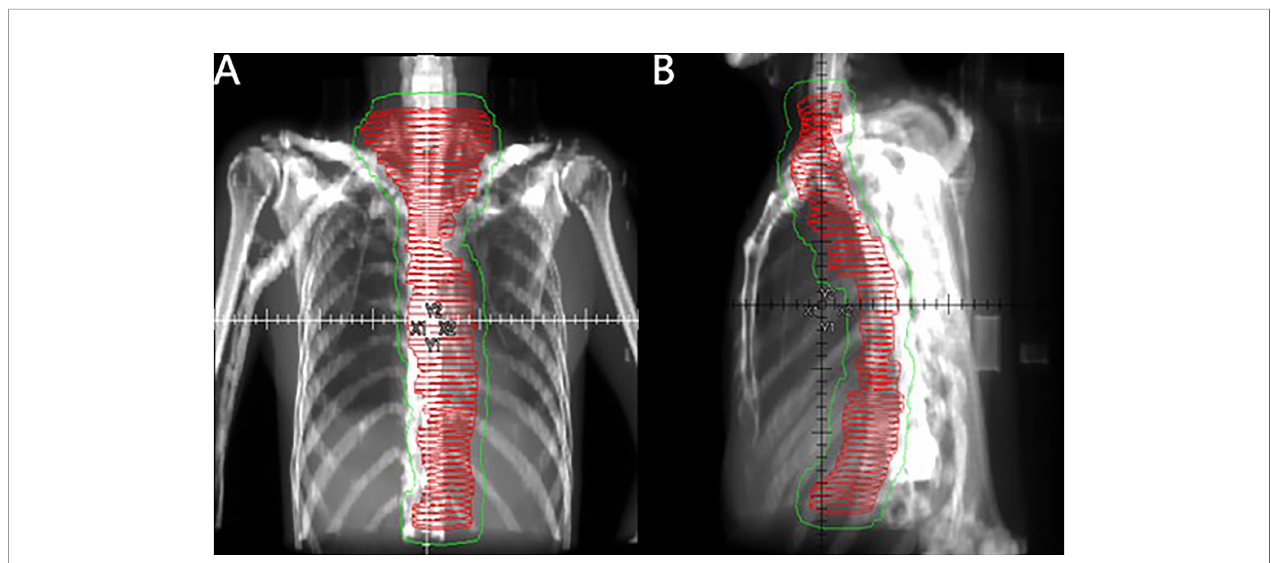
FIGURE 1 | Coronal (A) and sagittal (B) views of the CTV (red horizontal lines) and PTV (thin green line) of large- fi eld postoperative radiotherapy using the three- dimensional radiation